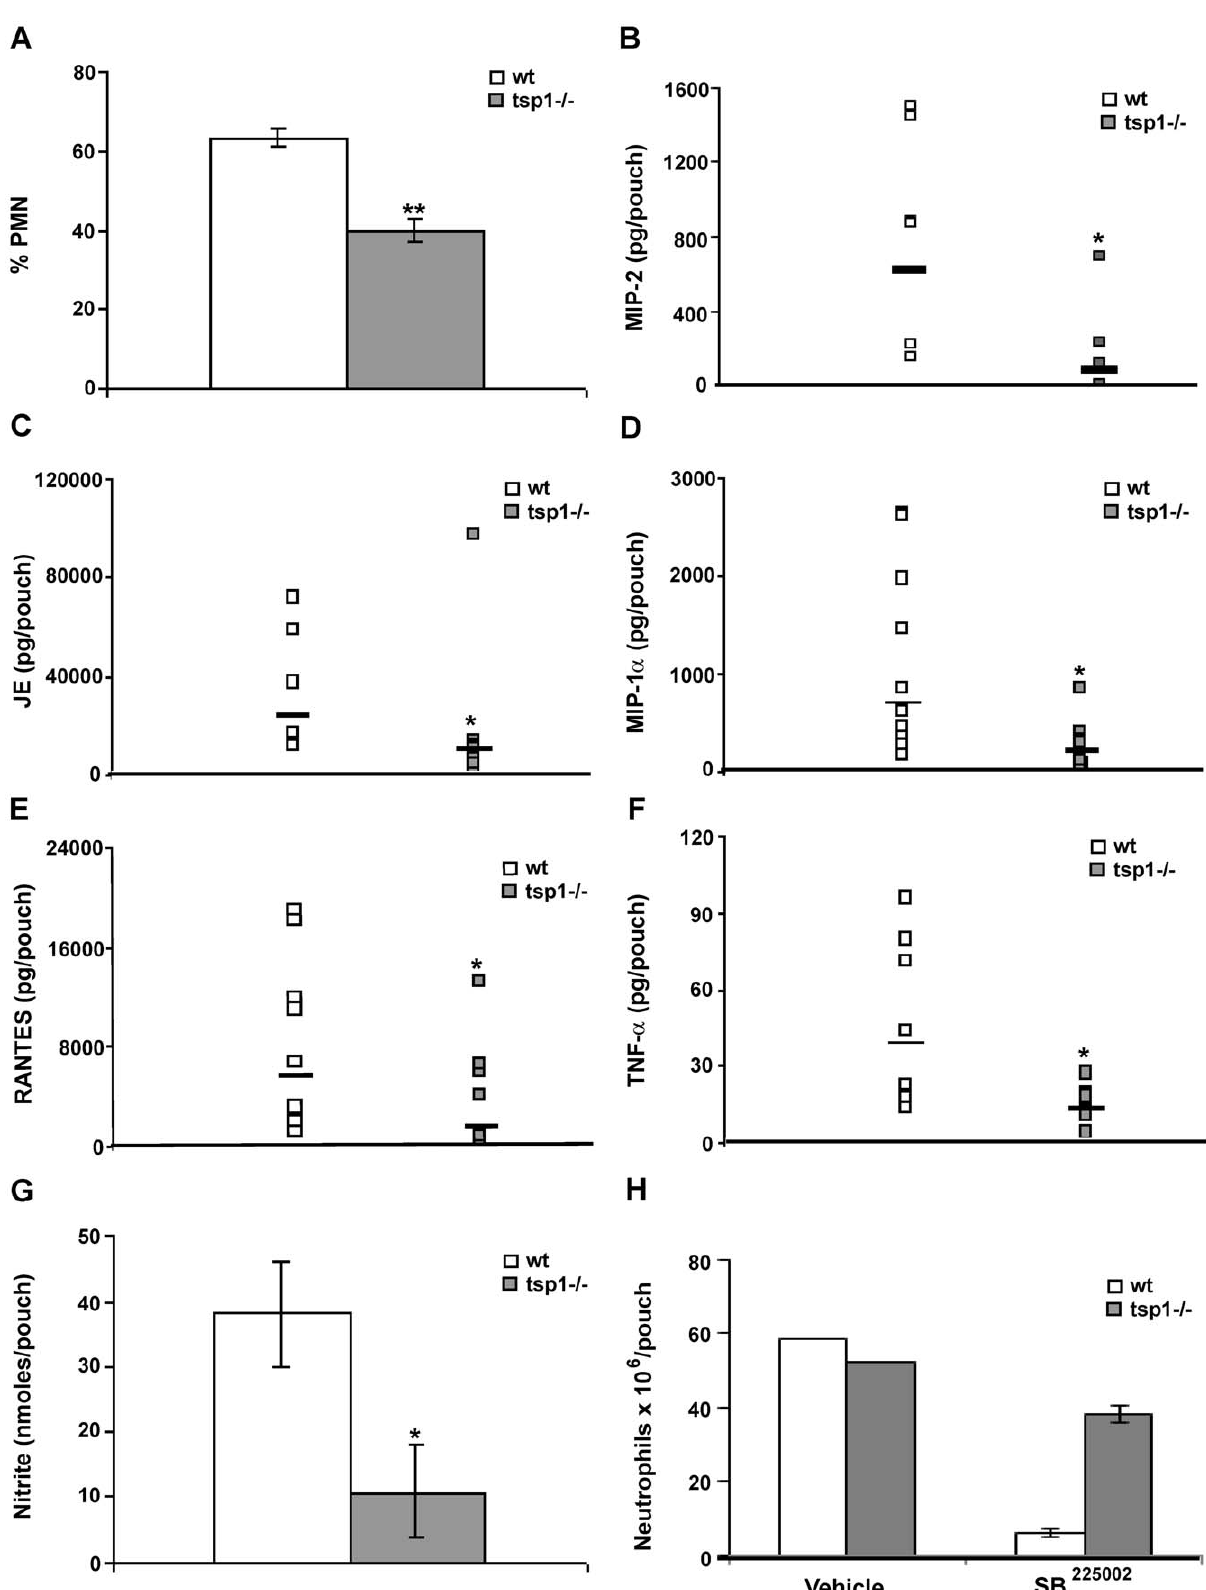
Figure 3. TSP1 increases PMN recruitment to sites of acute inflammation. Six day-old air pouches received 1 ml of 1% l -carrageenan, and the mice were sacrificed 24 h after injection. (A) The percentage of infiltrating PMN was quantified in 10 different 400 6 fields with inflammatory infiltrate. Bars, mean 6 SEM, n=5 2 6 mice/group. (B–F) The levels of mouse MIP-2, JE, MIP-1 a and RANTES, and TNF- a in the air pouch lavage were